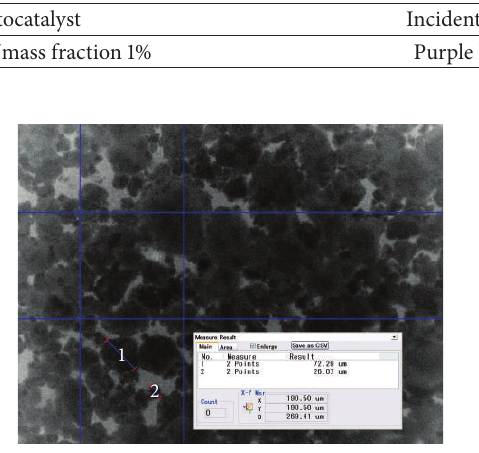
Figure 2: Cd 0.5 Zn 0.5 S photocatalyst in